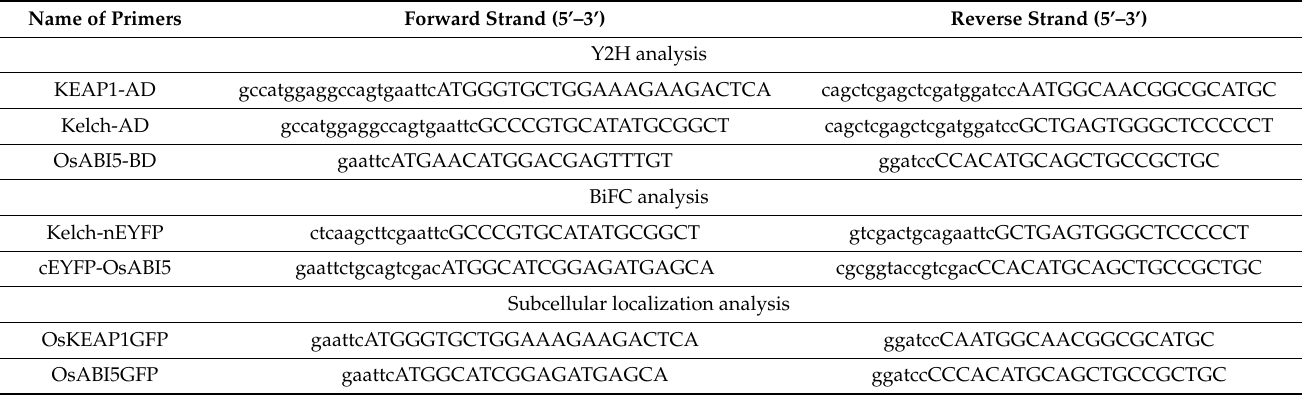
Table 1. Primers used for the Y2H, BiFC, and subcellular localization analysis. Name of